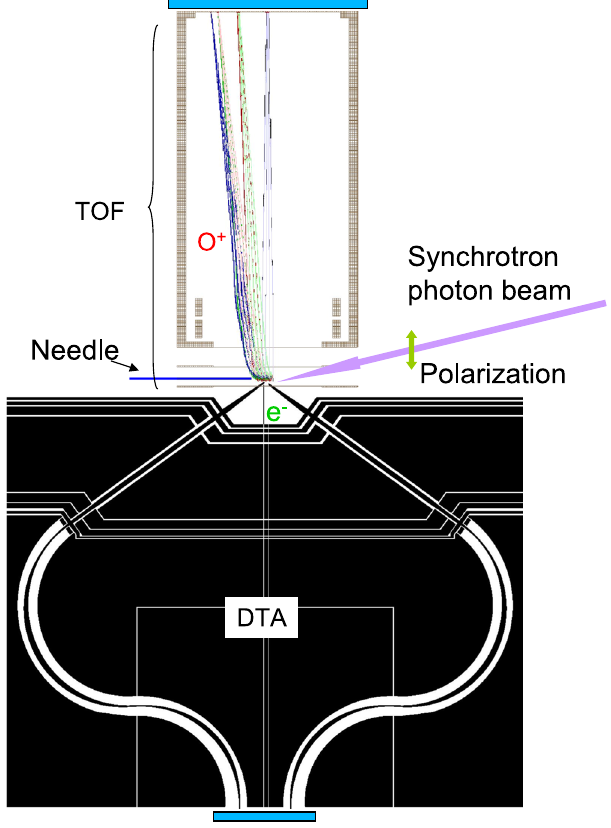
Figure 6. A schematic representation of the Auger electron-ion coincidence setup EPICEA 41 . Synchrotron radiation (SR) crosses an effusive beam of molecular oxygen from a non-magnetic metallic needle. Electrons are detected in a field-free region using an electrostatic Double Toroidal Analyzer (DTA), which collects electrons in the vicinity of the magic angle (54.7°) with respect to the symmetry axis 39 . The electron detection triggers a pulsed high voltage, which pushes ions into a 3-D focusing time-of-flight spectrometer. The ions with kinetic energies below 12 eV are collected. The kinetic energy and the emission angle of electrons, as well as the time of flight and the position of the ions, are recorded using two delay-line based position sensitive